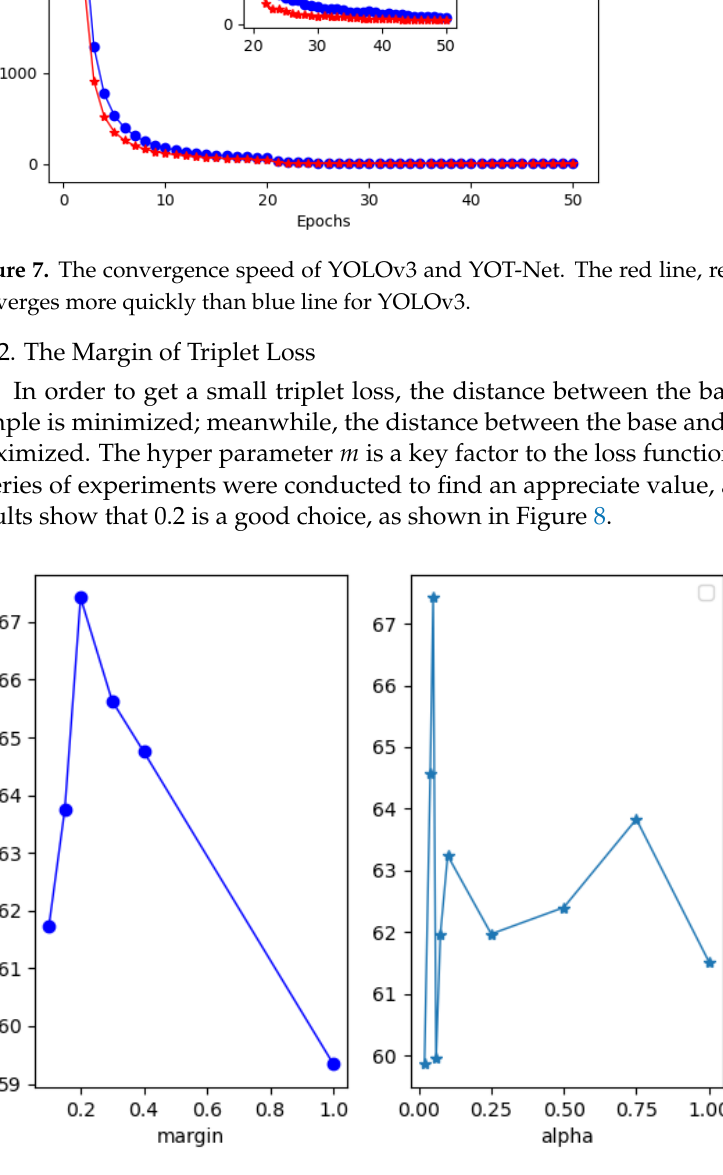
Figure 8. The effect on mAP of different values in margin and alpha. The left plot shows the effect of margin on mAP. The right plot shows the effect of alpha on